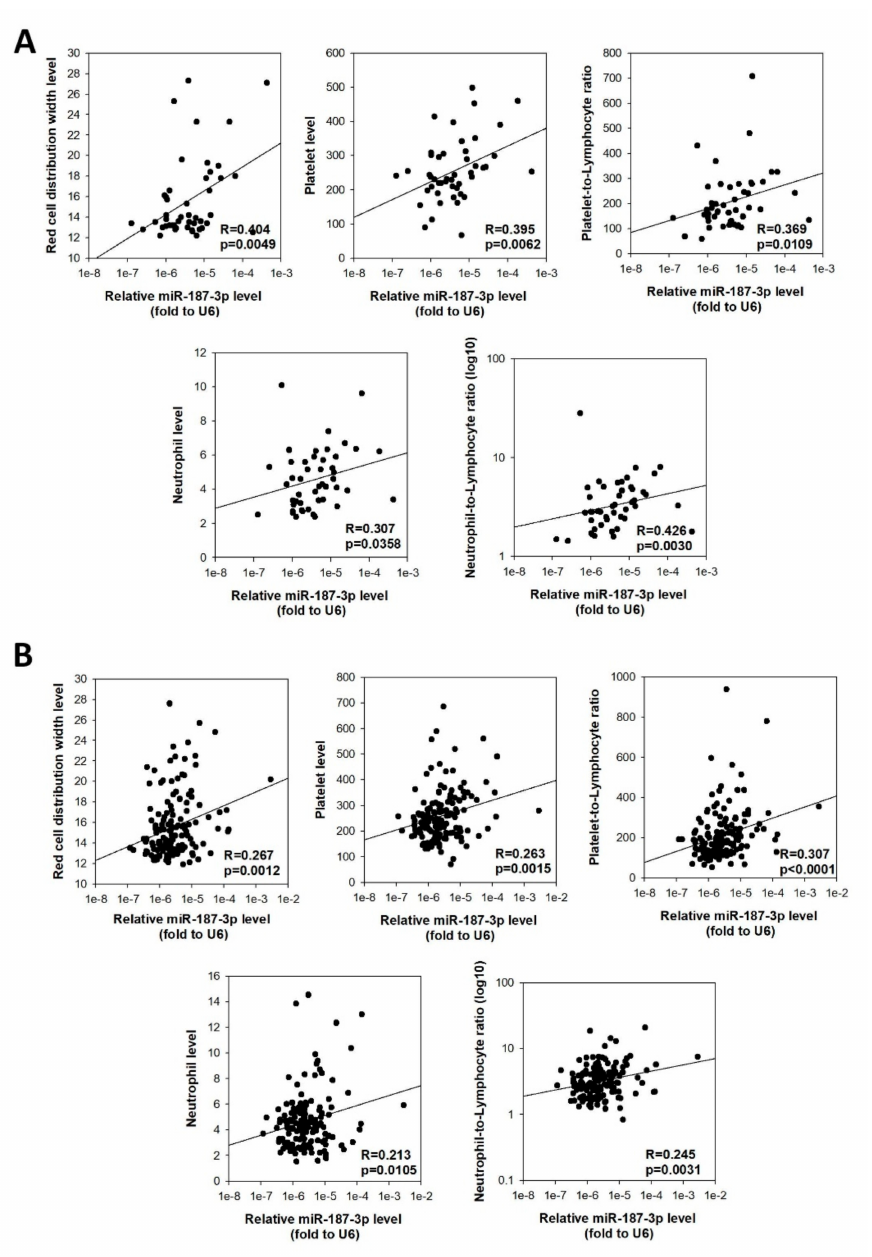
Figure 7. Tumor miR-187-3p levels were correlated with preoperative peripheral inflammation- related blood parameters: Positive correlation was found between tumor miR-187-3p levels and levels of red cell distribution width, platelet count, platelet-to-lymphocyte ratio, neutrophil count, and neutrophil-to-lymphocyte ratio for patients in the ( A ) study cohort ( n = 54) and ( B ) validation cohort ( n =